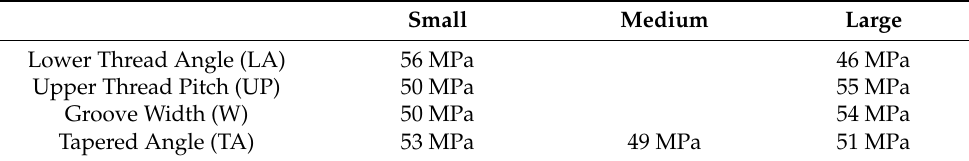
Table 5. Comparison of average stress on anchor of four different design factors in 10